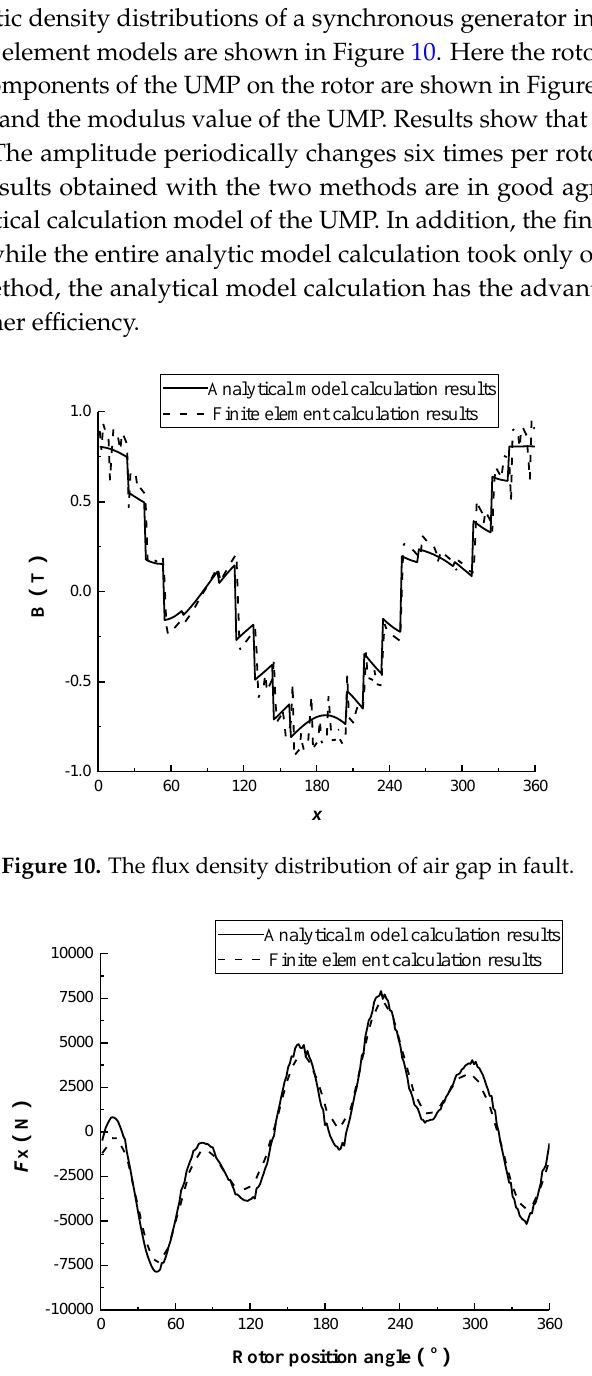
Figure 12. The Y -axis UMP of rotor in fault. 0 Figure 13. The UMP direction of rotor in fault.